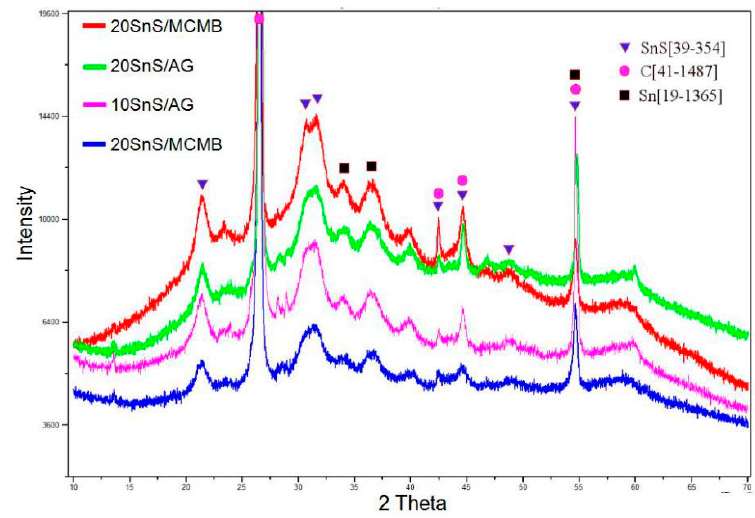
Figure 5. XRD of the SnS/C composites after 200 cycles.